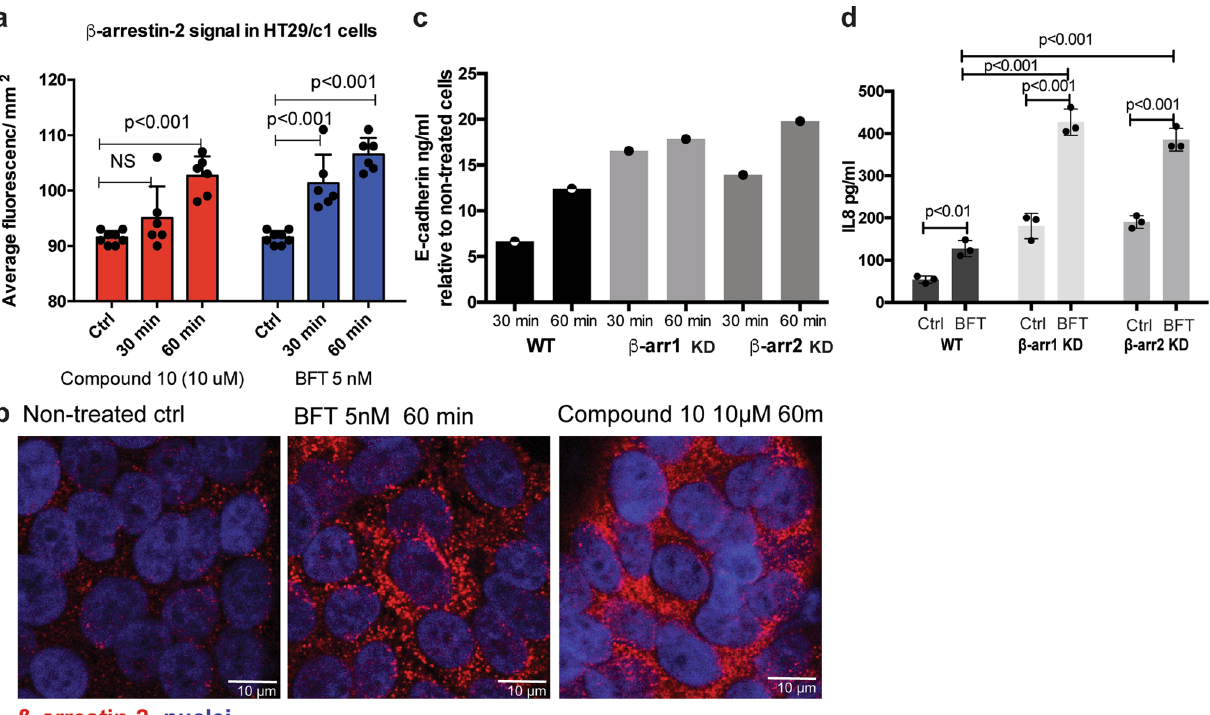
Fig. 3 β -arrestin signaling following BFT treatment. a The β -arr2 signal in HT29/c1 cells was increased after 30 and 60 min of treatment with BFT to levels similar to that of cells treated with the GPR35 agonist compound 10 ( P < 0.001, N = 6). Representative images of β -arr2 staining are shown in ( b ) at ×400 magni fi cation. c E-cadherin cleavage with the release of the E-cadherin extracellular domain was enhanced in β -arr1 and − 2 KD cells after both 30 and 60 min of BFT treatment compared to control BFT-treated HT29/c1 cells ( N = 1). d Baseline IL-8 secretion was increased in β -arr1 and − 2 KD cells compared to control cells ( P < 0.001, N = 2 each). While IL-8 secretion after BFT treatment was increased in the β -arr1 and β -arr2 KD ( P < 0.001), the overall fold change in IL-8 secretion (BFT vs nontreated ctrl) was similar in β -arr1 amd β -arr2 KD cells compared to control